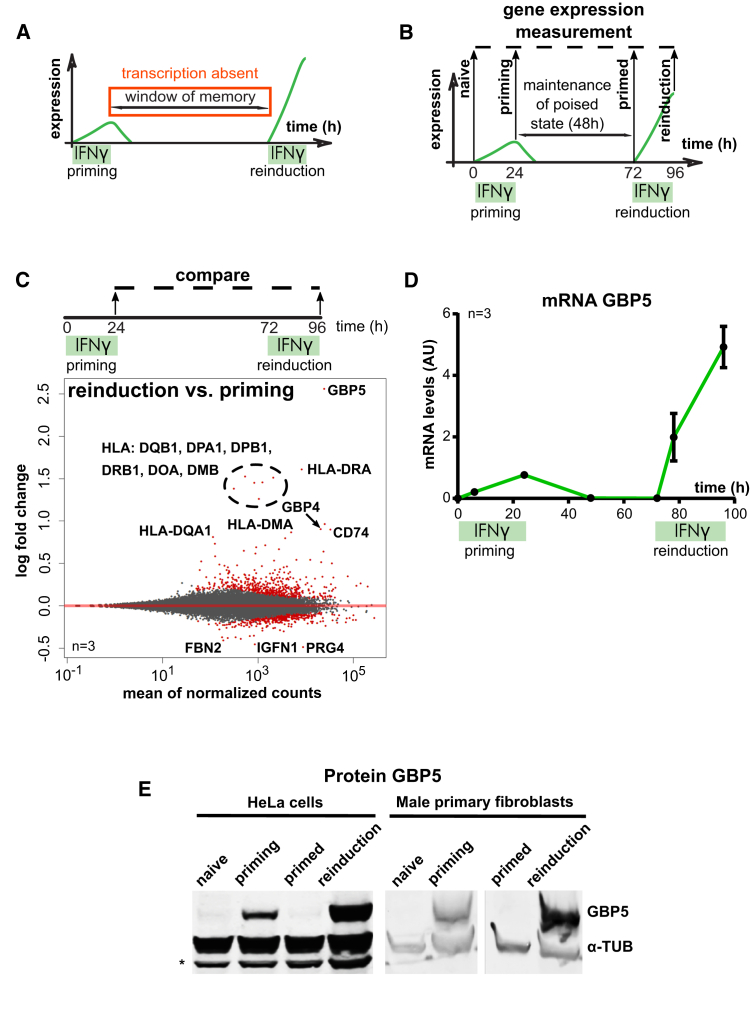
Long-Term Transcriptional Memory of Genes Following Priming with IFNγ(A) Principle of cytokine-induced transcriptional memory.(B) Experimental outline of the transcriptional memory experiment.(C) Plot showing differential rates of reinduction relative to priming as measured by RNA-seq. Average read counts for three replicate experiments, as outlined in (B), were assembled for each gene. The log2 fold change of the gene read count following reinduction over those following priming is plotted. “0” indicates no change, whereas positive values indicate increased expression upon reinduction. Data were ranked according to the mean expression level for both of the conditions and all replicates. Genes that show strong transcriptional memory or tolerance (reduced expression upon reinduction) are labeled. Red dots represent genes with a p-adj value below 0.1.(D) HeLa cells were primed and reinduced according to the regimen outlined in (B). GBP5 mRNA levels were quantified by RT-qPCR and normalized to ACTB expression. Error bars, SD; n = 3 biological replicates.(E) HeLa cells and human male primary fibroblasts were subjected to the IFNγ treatment regimen outlined in (B), processed for western blotting, and probed for GBP5 protein expression. α-Tubulin (α-TUB), loading control; ∗, cross-reacting band.See also Figure S1.